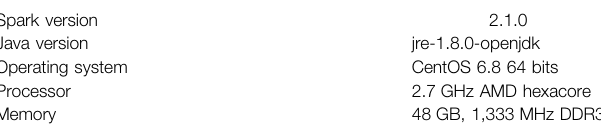
TABLE 3 | Experiment cluster node speci fi cations.